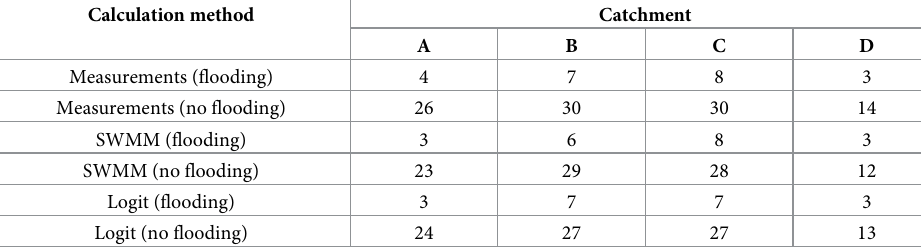
Table 2. Number of flooding events of logistic regression, SWMM and measurements in catchments A, B, C, and